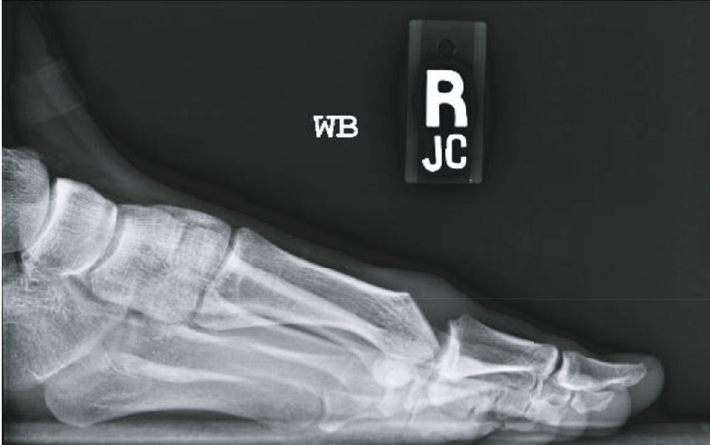
Figure 2: Preoperative right foot lateral radiograph taken at the time of presentation showing prior dorsal